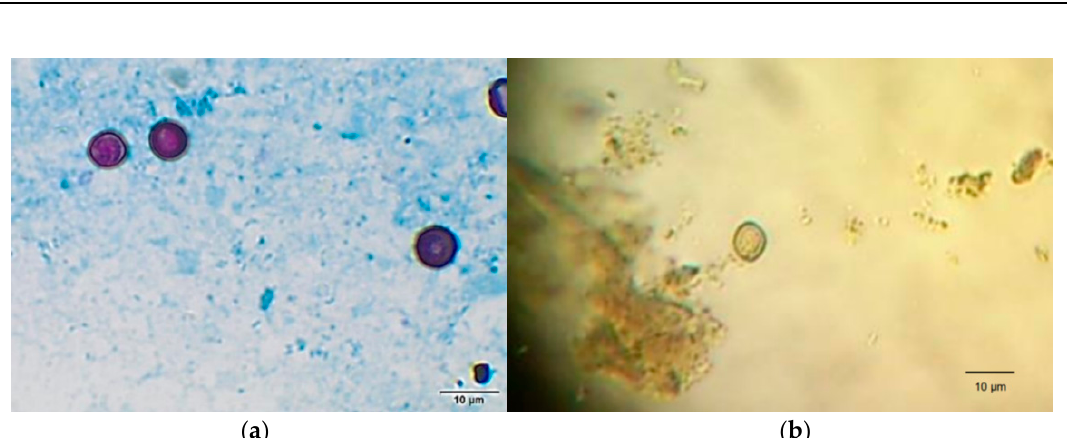
Figure 2. Microscopical analyses of intestinal content of Monk Parakeets. ( a ): Cryptosporidium spp. oocysts detected via Ziehl–Neelsen staining (1000×); ( b ): Giardia spp. cyst detected via Telemann method and stained using an iodine solution (400×).